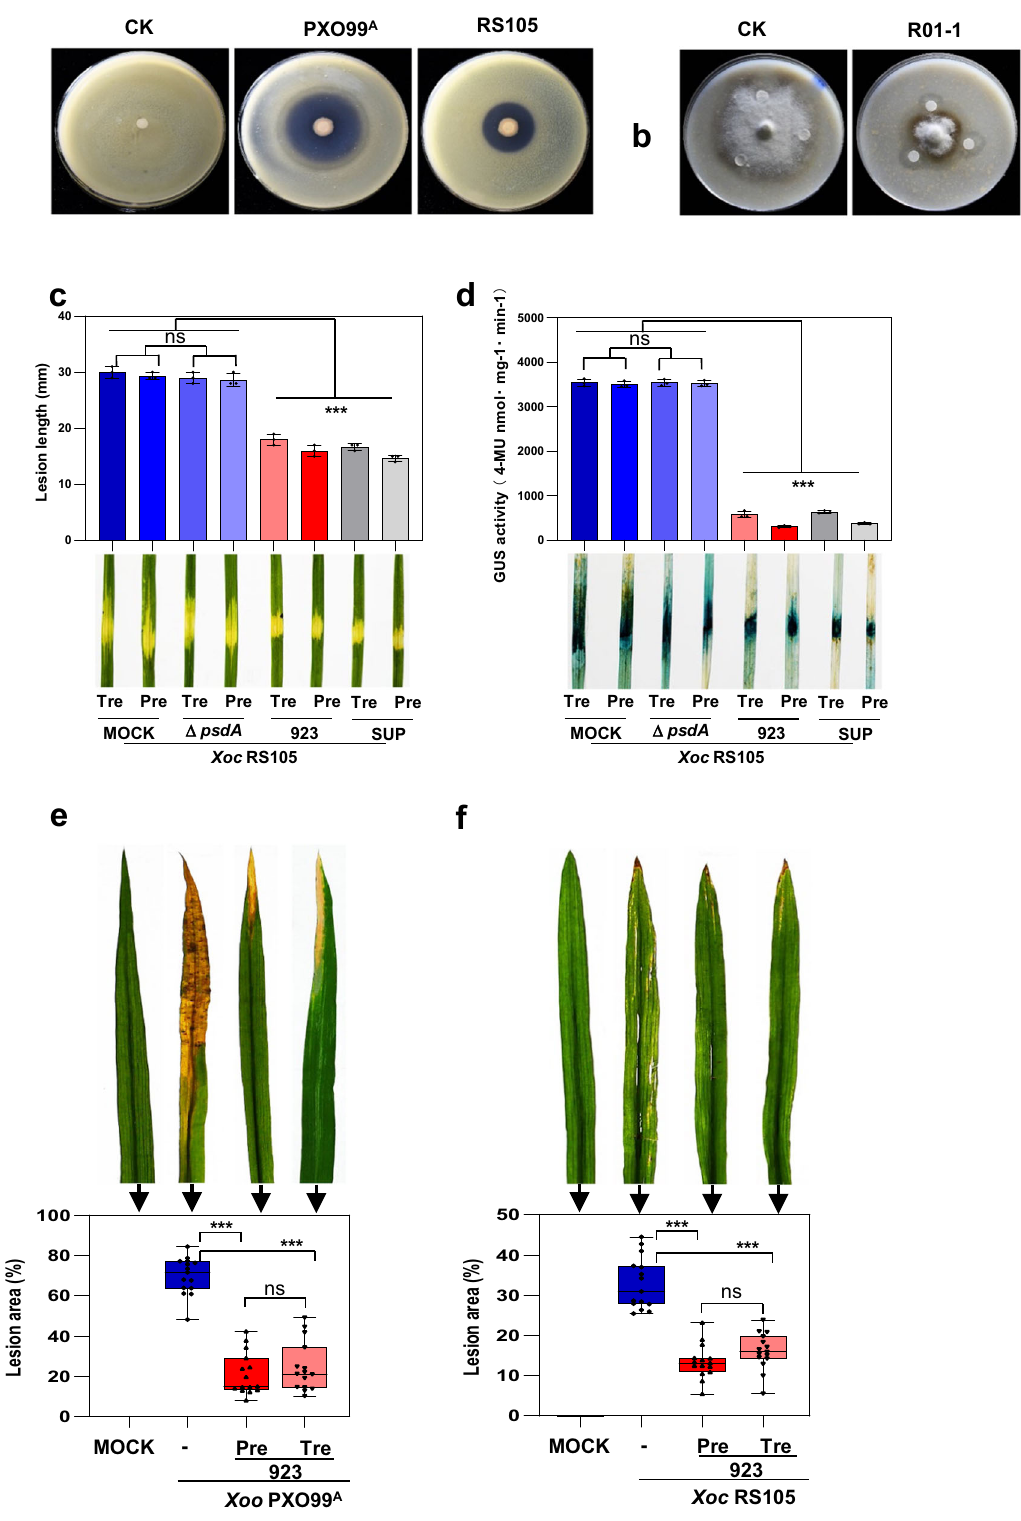
(Supplementary Fig. 10b – d). In order to identify whether pseudoiodi- nine is suf fi cient to protect rice leaves from lesions, we retested the biocontrol activity of mutant Δ psdA and WT of P. mosselii 923 on rice seedlings and adult plants. Leaves inoculated with the deletionmutant Δ psdA exhibited lesion lengths and the GUS activity equivalent to the MOCK treatment (Fig. 1c, d). Meanwhile, we tested the effects of mutant Δ psdA , WT P. mosselii 923 and pseudoiodinine on the growth